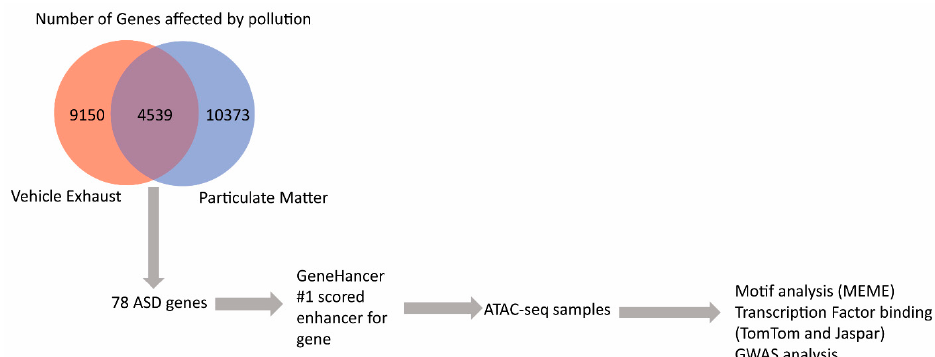
Figure 1. Flow chart of analysis. Data from the publicly available comparative toxicogenomic database (CTD) identified 4539 genes that were differentially expressed following exposure to both vehicle exhaust and particulate matter. Genetic studies have implicated 78 of those genes in autism spectrum disorder (ASD). Enhancer regions for these 78 genes were identified and analyzed for differential accessibility by ATAC-seq on DPM-exposed human neural progenitor cells. Motif analyses of the open chromatin identified transcription factor binding sequences.